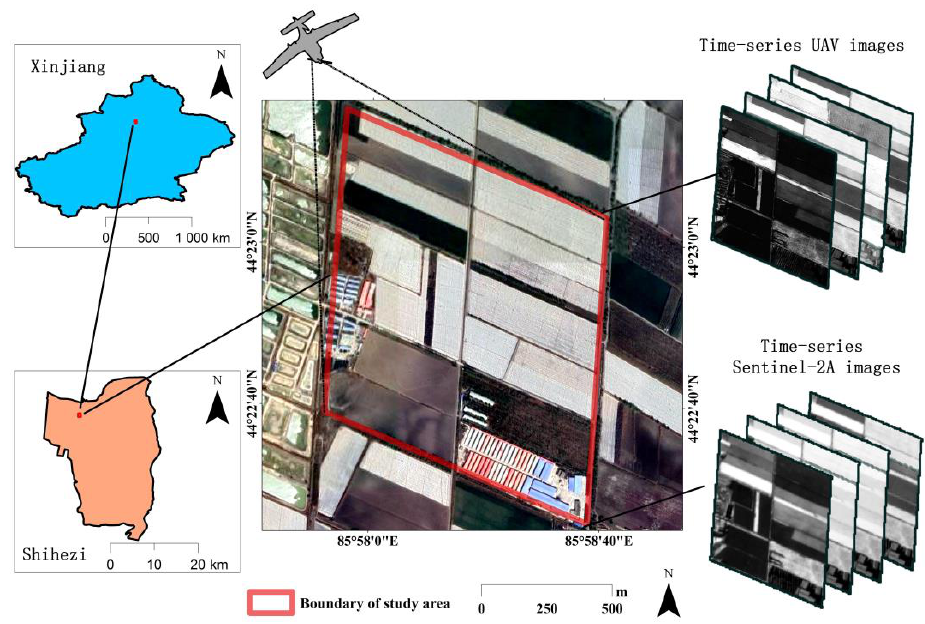
Figure 1. Geographic location and time-series UAV and Sentinel remote sensing images of the study